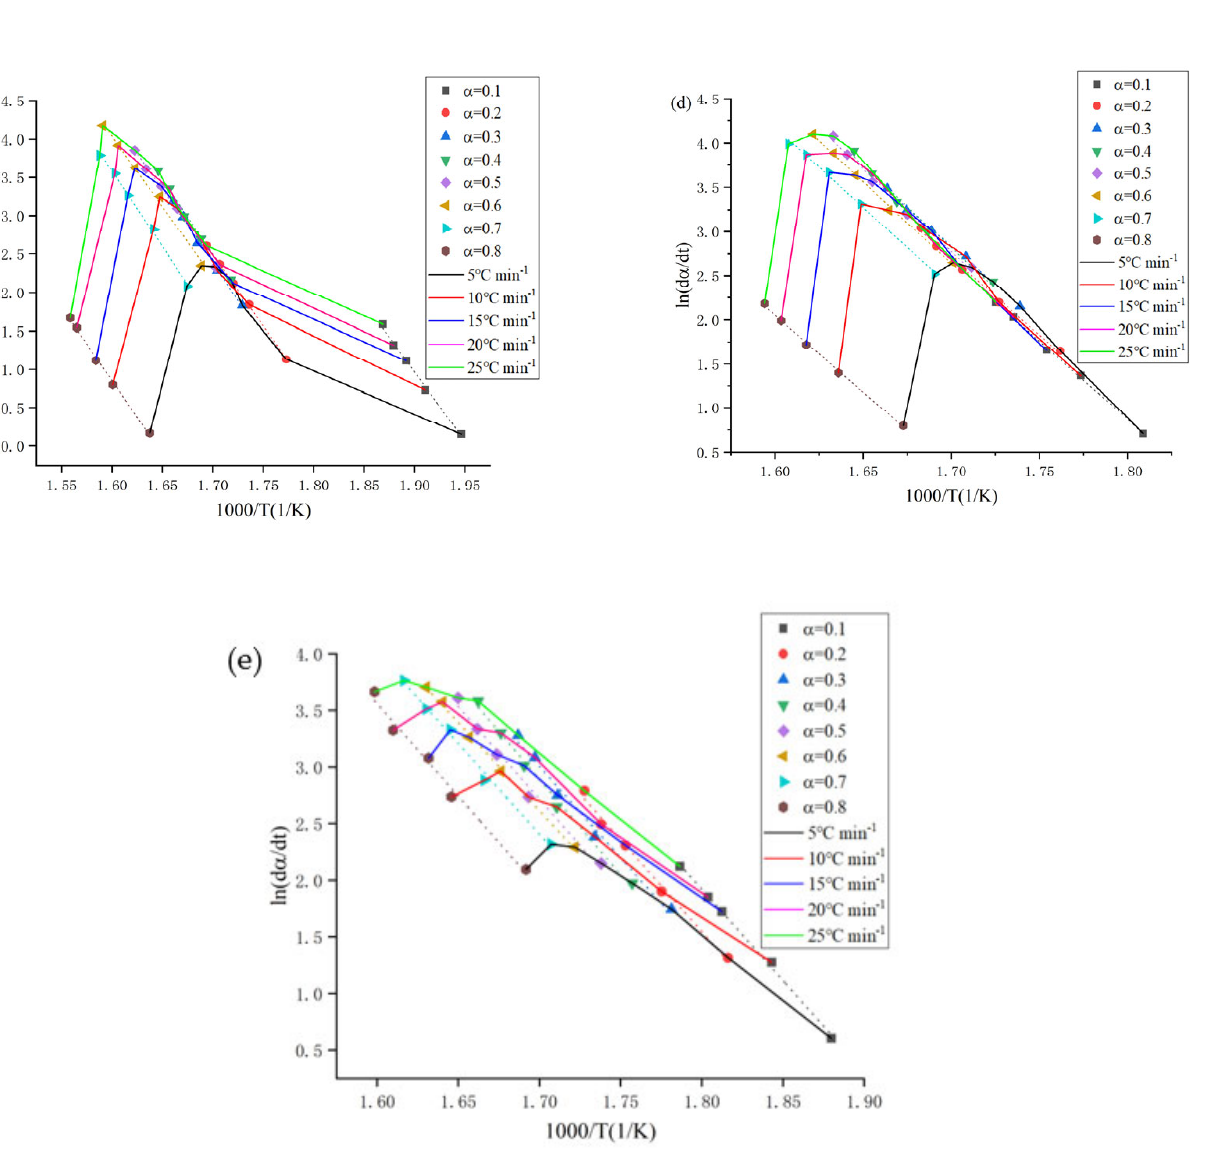
Figure 6. Fitting results of the Friedman method for [Emmim][NO 3 ] ( a ), [Bmmim][NO 3 ] ( b ), [Hmmim][NO 3 ] ( c ), [Ommim][NO 3 ] ( d ) and [Dmmim][NO 3 ] ( e ).